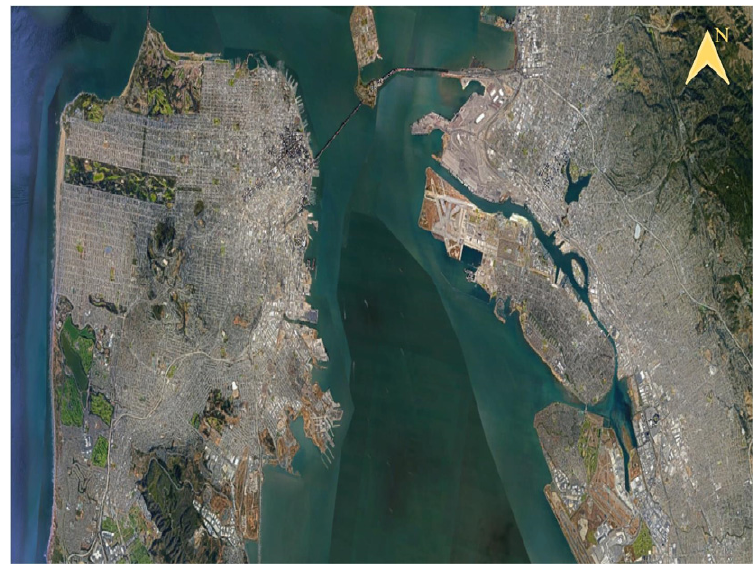
Figure 7. Optical image of the observed area from Google Earth.